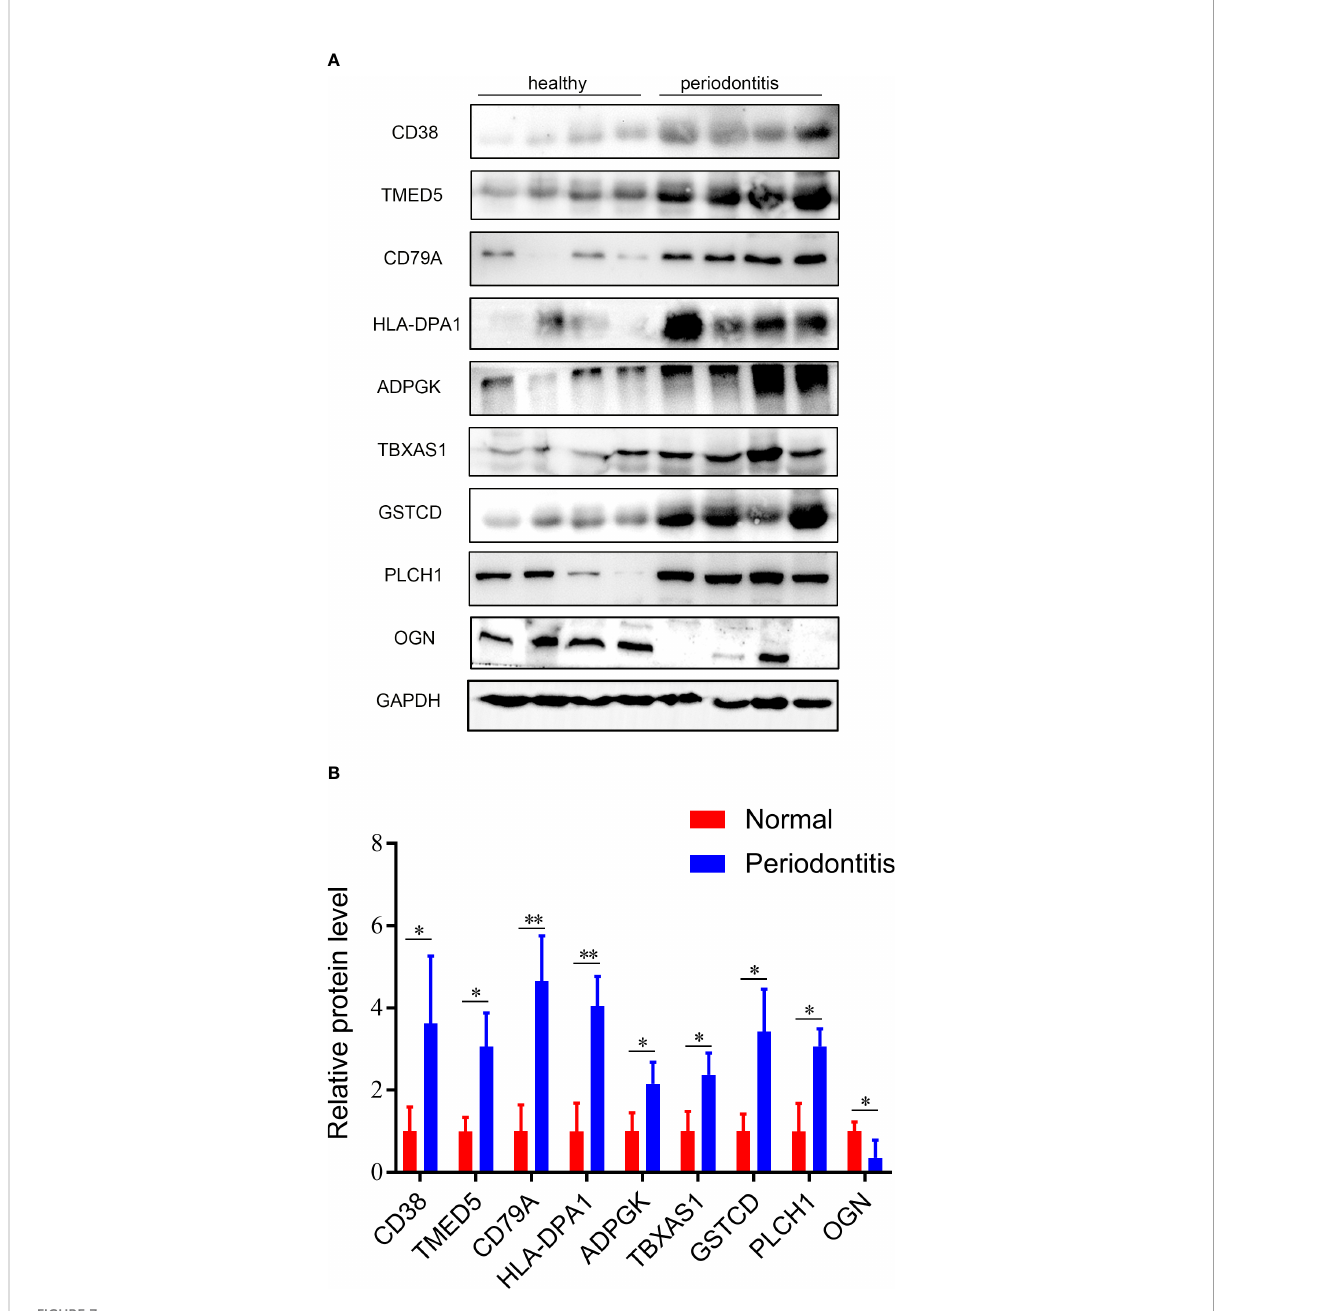
FIGURE 7 Validation results of western blotting. (A) Validation of the 9 hub DEPs by western blotting. GAPDH was used as a loading control. (B) Quantitative results of western blotting from Fig 7A. Data are represented as the mean ± SD. *p <